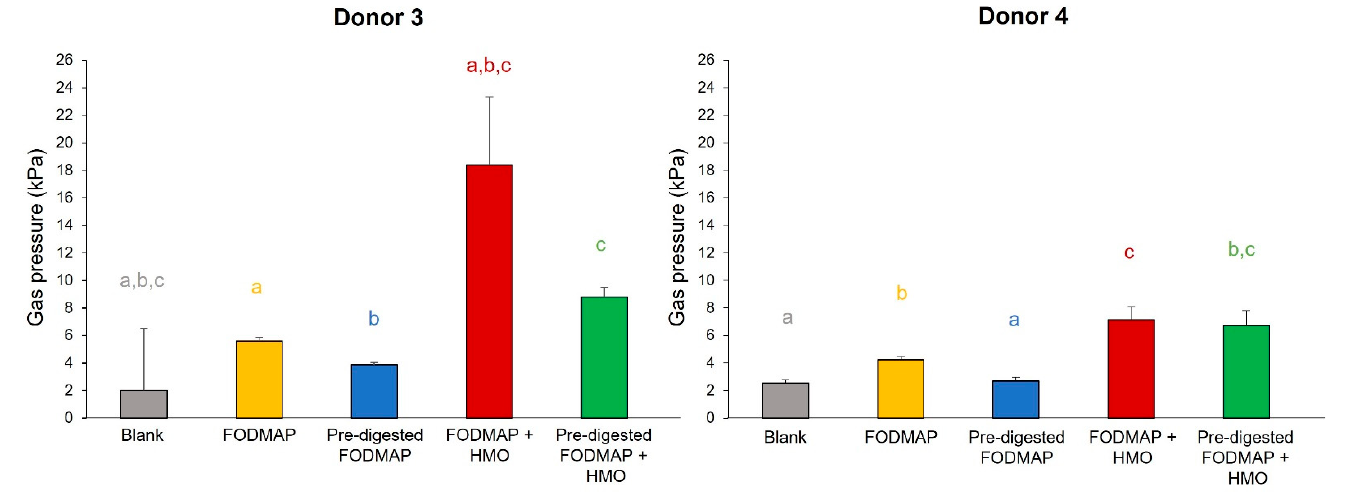
Figure 5. Changes in gas pressure using samples from the QuintSHIME ® model. Supernatants were collected from the QuintSHIME ® model on day 9 (treatment period) and evaluated in the short-term colonic batch model (48 h) to evaluate gas pressure ( n = 2 for each donor). Gas pressure evaluations during different time intervals of colonic incubation are shown. Different letters represent statistically significant differences between the different test conditions ( p < 0.05). FODMAP = fermentable oligosaccharides, disaccharides, monosaccharides, and polyols; HMO = human milk oligosaccharide; SHIME = simulator of the human intestinal microbial ecosystem.